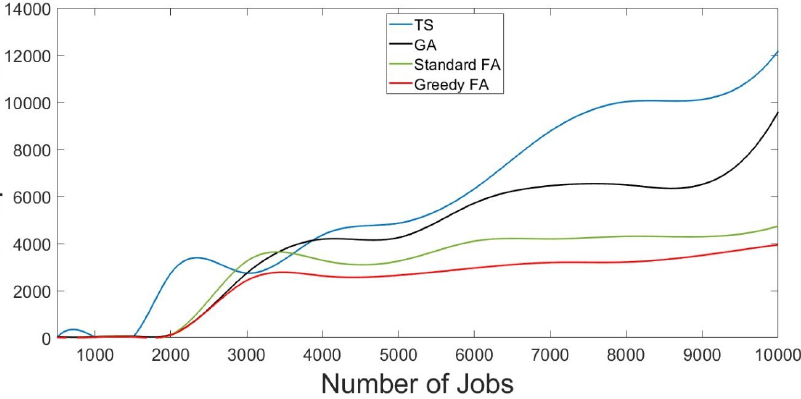
Figure 7. Makespan times of GFA Compared to Different Scheduling Methods for Different